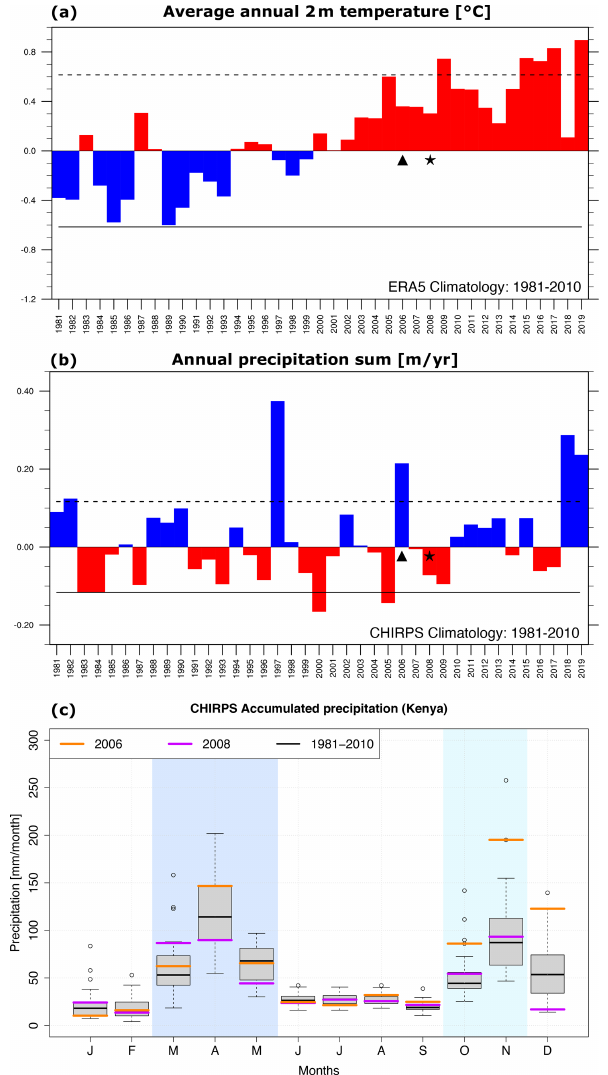
Figure 2. Annual anomalies of mean 2m temperature (in ◦ C) from ERA5 (Copernicus Climate Change Service, 2017) (a) and of pre- cipitation (in metres per year) from CHIRPS (Funk et al., 2015) (b) . The anomalies are calculated with respect to the climatological mean of the years 1981 to 2010. The stippled (straight) lines il- lustrate plus (minus) 1 standard deviation. Monthly accumulated values of precipitation (in millimetres per month) for the selected year 2008 (in purple) and 2006 (in orange) compared to the cli- matology (1981–2010, in grey, using a box and whisker plot) are shown in (c) . All values are means over the territory of Kenya in each subplot. The whiskers extend to the value that is no more than 1.5 times the interquartile range away from the box. The values out- side this range are defined as outliers and are plotted with dots. The dark blue and light blue shading indicate the long rains and short rains,